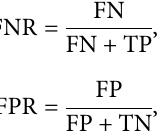
Figure 12: The SSA-based model optimization